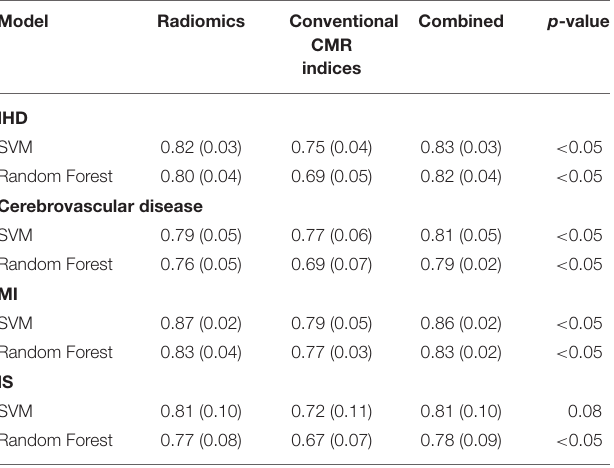
TABLE 2 | Comparing the degree of discrimination achieved using radiomics only, conventional CMR indices and both (combined model) for each disease group. Model Radiomics